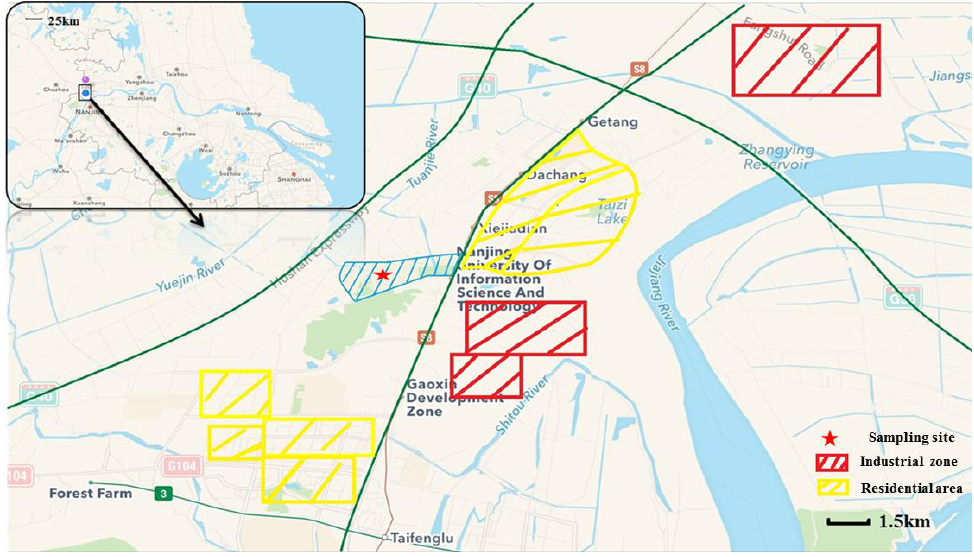
Figure 1. Location of sampling site in Nanjing, Jiangsu Province, the eastern China.